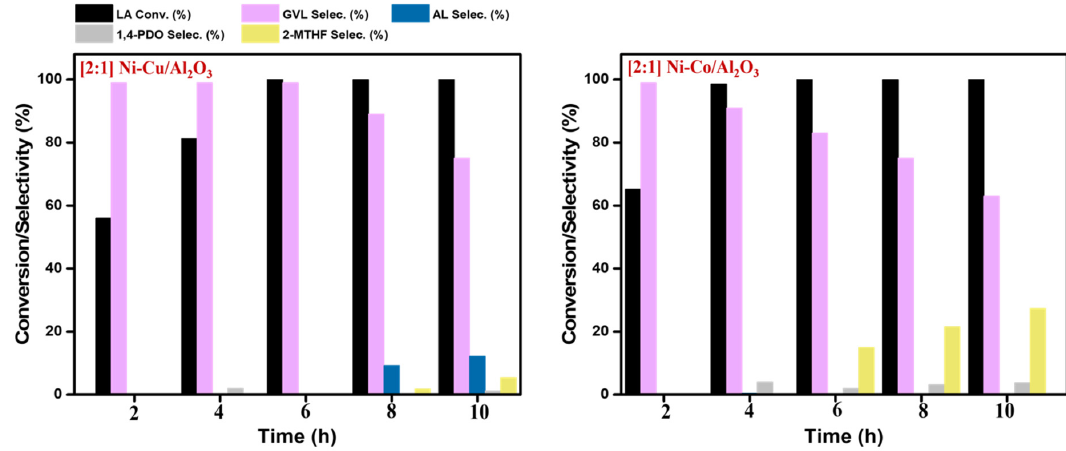
Figure 11. Reaction results for the effect of reaction time on the hydrogenation of LA. Reaction conditions: 20 mL LA, 1 g catalyst, 220 °C, 30 bar H 2 pressure.